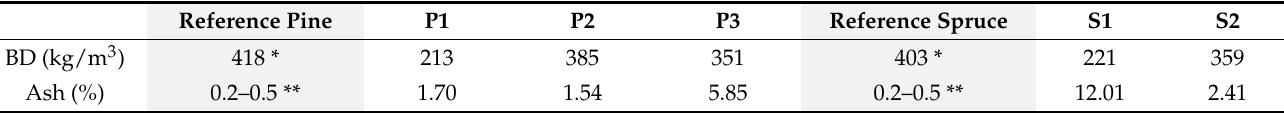
Table 4. BD and percentage ash content in the collected